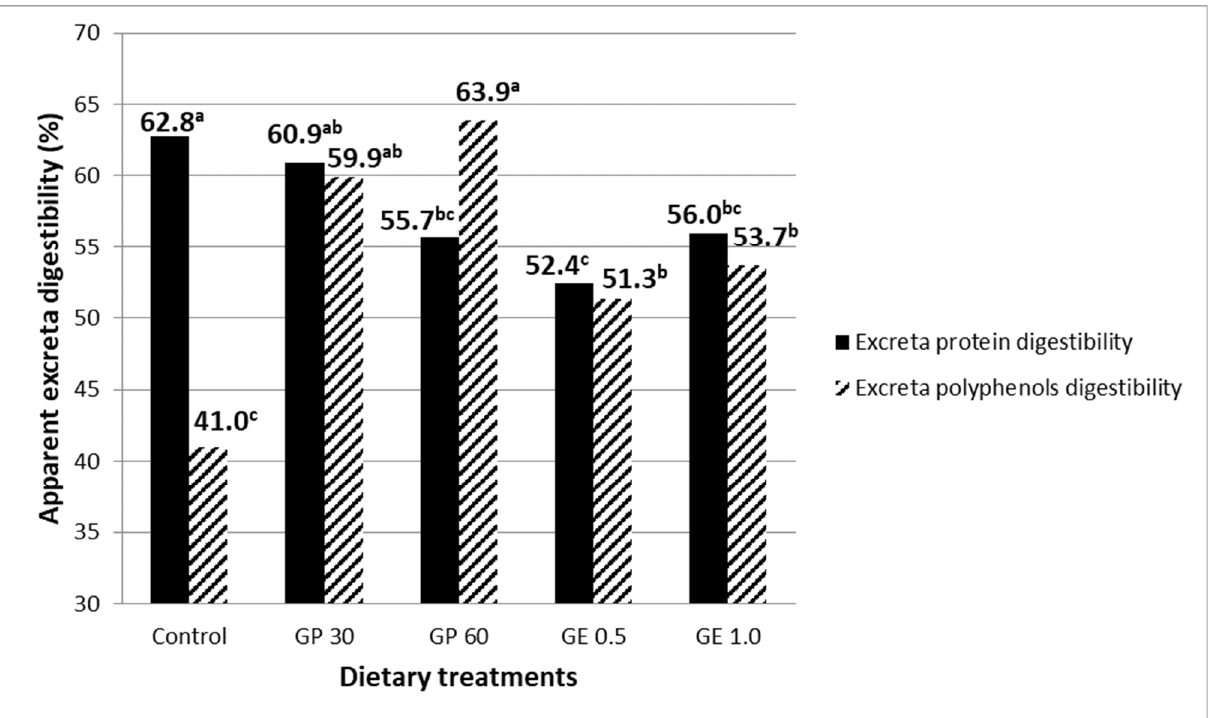
Figure 1. Excreta digestibility of protein (SEM 1 = 1.64, *** ) and that of total extractable polyphenols (SEM = 2.86, *** ) in laying hens fed diets containing grape pomace (GP) or grape extract (GE) at different concentrations. Different letters for the same parameter (a, b, c) indicate significant dif-